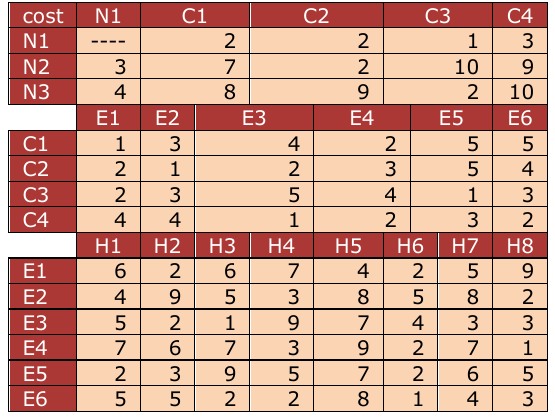
Figure 4. Demand in EDH 1 by the two different methods